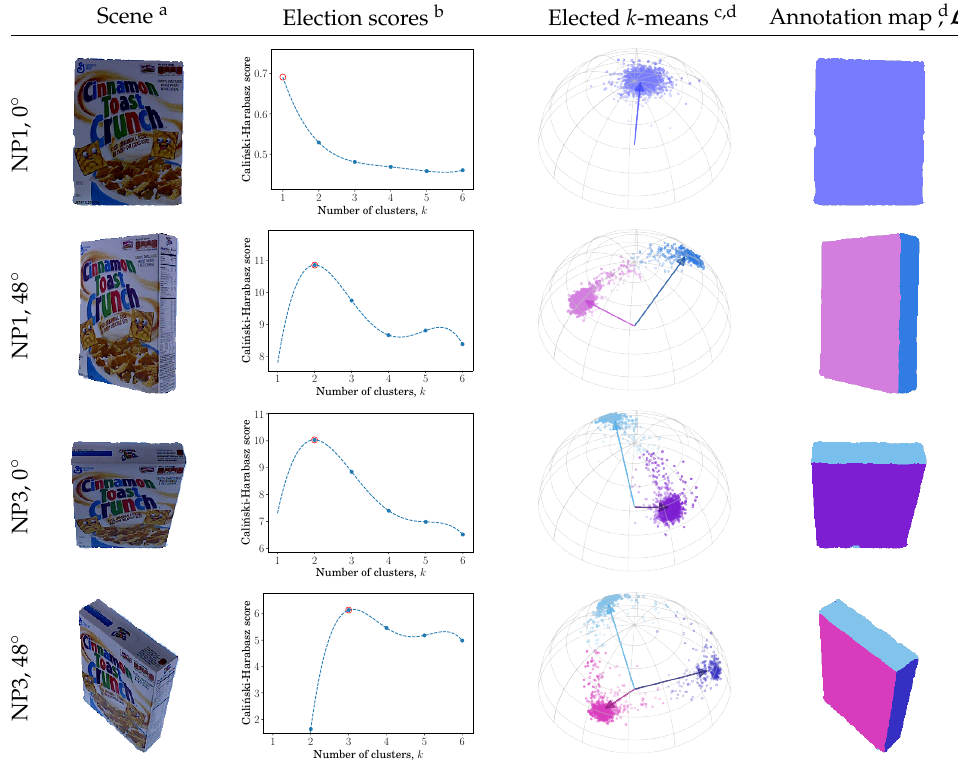
a Surface-normals maps are utilized as input, while RGB images are shown for demonstration purposes. b The solid blue dots represent the measured scores. The dashed blue curves are polynomials fit over the measurements and extrapolated to the single-cluster case. The red circles denote the highest score. The non-integer k values of the extrapolation curves are for demonstration only, as they are not actually utilized nor have any meaningful interpretation. c The k -means model corresponding to the highest score. Cluster n centroids, , are depicted by the arrows. Perspective is observed from a 45 ◦ elevation and 120 ◦ azimuth. − { } d Up to a rotation, RGB colors in the elected k -means and the annotation map columns encode the orientations in the 3D space. Figure 2. Clustering on the unit hemisphere. For each input, several spherical k -means models were constructed in parallel from the surface-normal map. Their Cali´nski–Harabasz scores were determined, where the score for the single-cluster was extrapolated. The highest-scoring k -means model was selected, and its clusters were back-projected to the pixel space to form the annotation map. NP1 and NP3 are two cameras fixed at 88.4 ◦ and 38.1 ◦ elevation angles, respectively.